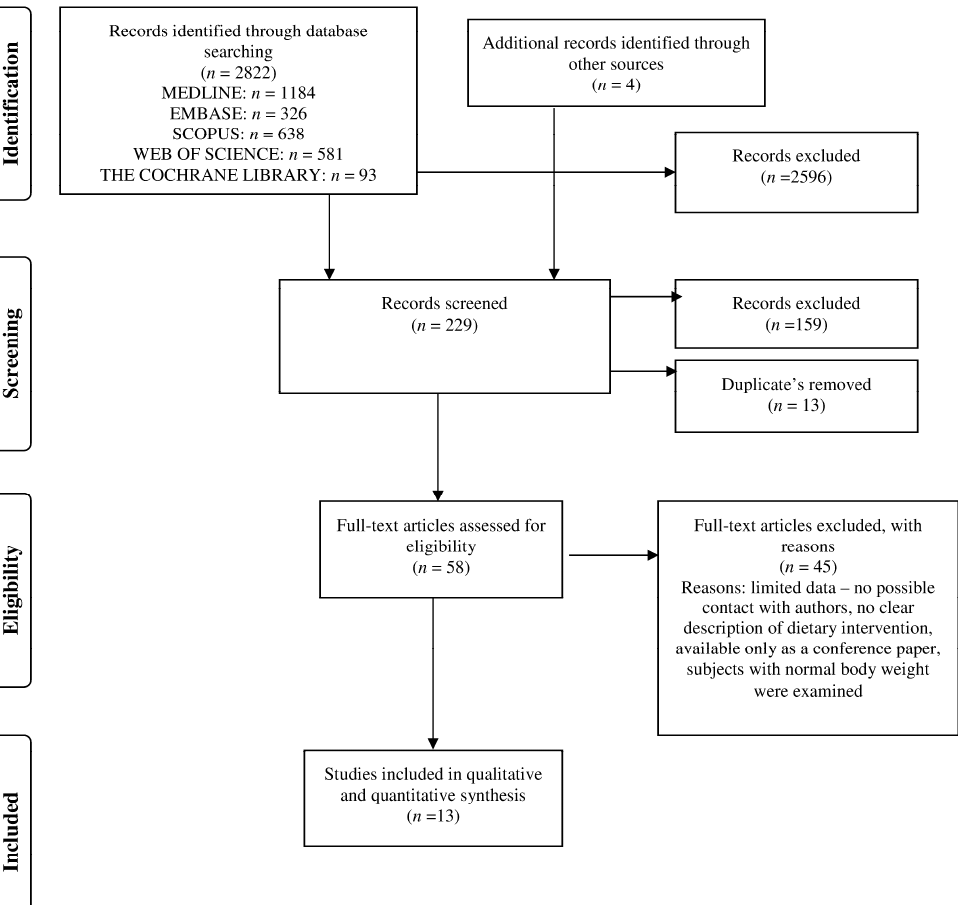
Figure 1. Process of literature search on the association between food energy density and body weight changes in obese